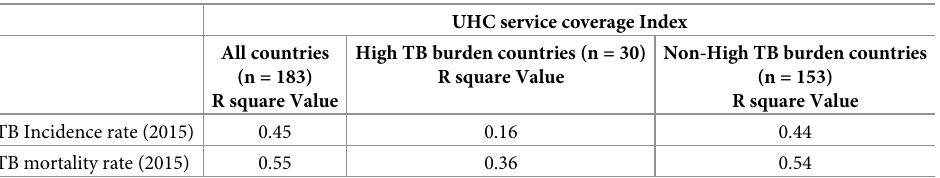
Table 2. Multivariate regression analysis assessing association of TB incidence rate and TB mortality rate with UHC SCI scores; multivariate models stratified based on TB